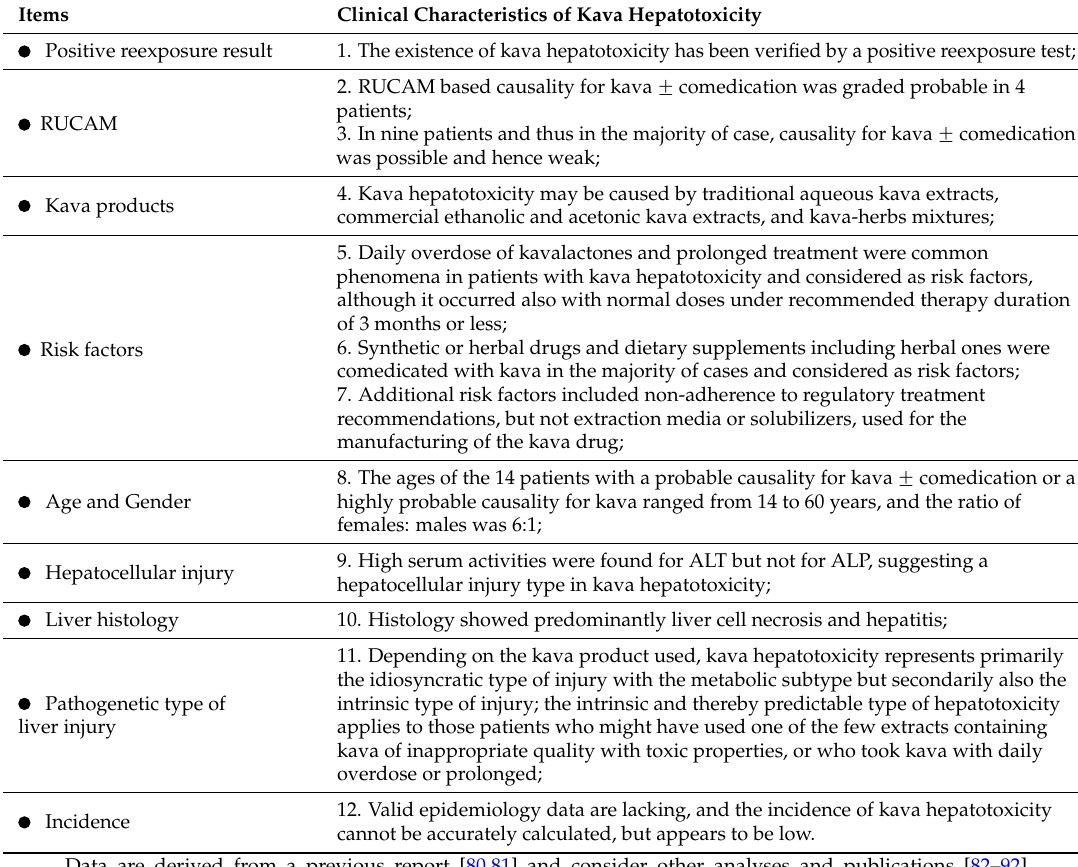
Table 5. Clinical characteristics of kava hepatotoxicity.